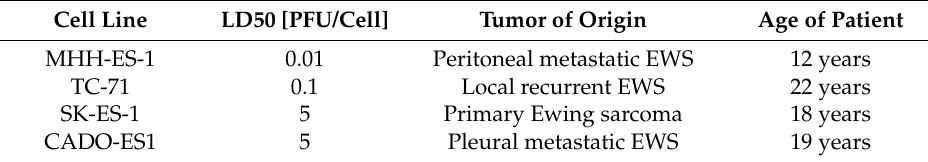
Table 1. Origin of the Ewing sarcoma (EWS) cell lines and ED50 of H-1PV as determined by cytotoxicity